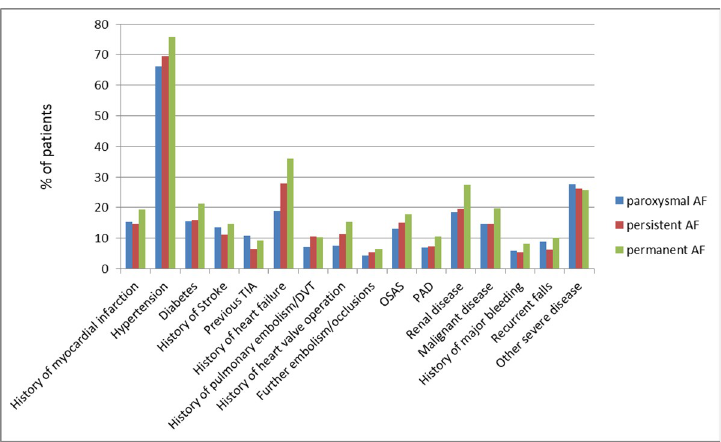
Fig 1. Frequencies of comorbidities according to AF type. TIA, transient ischemic attack; DVT, deep vein thrombosis; OSAS, obstructive sleep apnoea syndrome; PAD, peripheral artery disease.